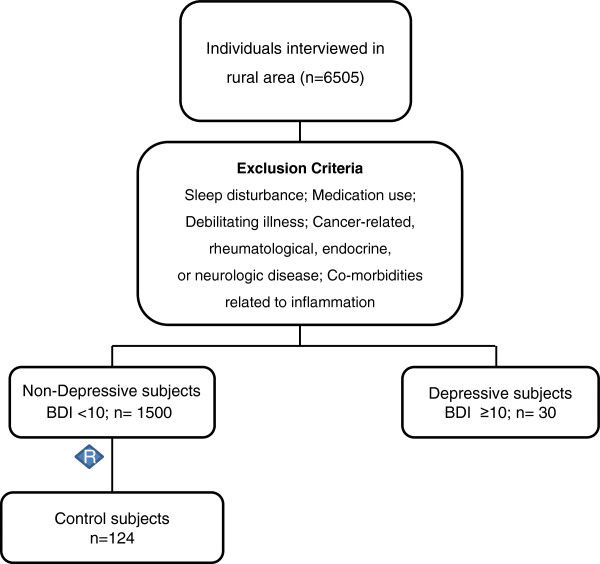
Flowchart of the inclusion procedure.